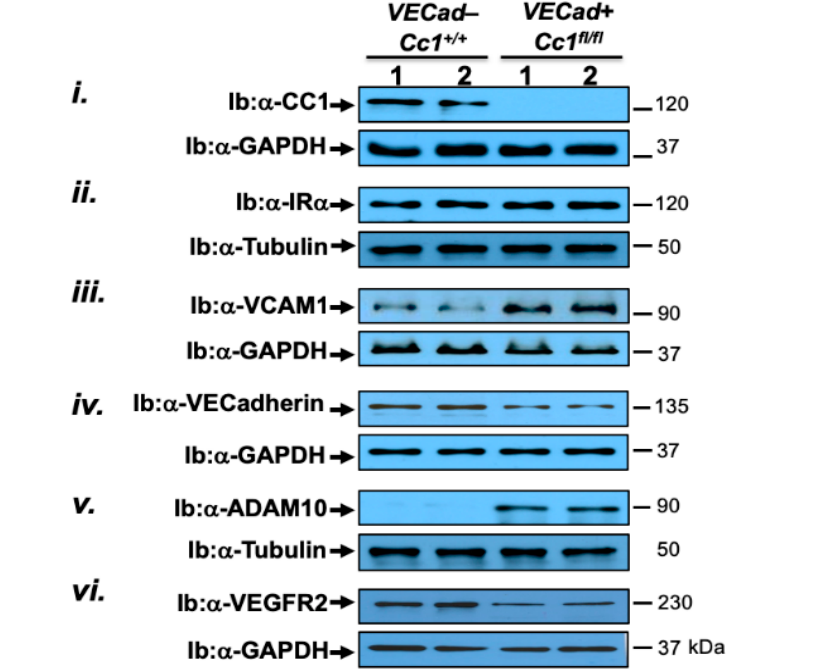
Figure 1. Assessing CEACAM1 expression in endothelial cells. ( A ) Primary cells were isolated from male mice at 2 months of age ( n = 5/genotype), except for hepatic stellate cells that were de- rived from male mice at 8 months of age. Ceacam1 mRNA levels were analyzed by qRT-PCR in triplicate and normalized to 18S. Values are expressed as mean ± SEM. * p < 0.05 vs. all control groups; Negl, negligible. ( B ). Liver endothelial cells (LEC) combined from several wild-type ( VECad-Cc1 +/+ ) and null ( VECad+Cc1 fl/fl ) mice were analyzed by immunoblotting (Ib) with specific antibodies ( α -) to detect specific proteins and normalized against levels of loaded proteins by im- munoblotting parallel gels or lower half-gels with α -GAPDH or α -Tubulin. The apparent molecu- lar mass (kDa) is indicated at the right-hand side of each gel. Gels represent two separate/repeated experiments. 3.2. VECadCre+Cc1 fl/fl Mice Display Insulin Sensitivity Compared to control littermates, VECadCre+Cc1 fl/fl nulls exhibited normal body weight for up to 12 months of age (Figure 2A, data of 8-month-old mice are shown). This was associated with normal visceral adipose mass (Figure 2B). Consistently, plasma levels of NEFA, adiponectin, and leptin were also normal in nulls relative to control littermates (Figure 2C–E, respectively). Null mice displayed normal steady-state plasma insulin (Figure 2F) and C-peptide (Figure 2G) levels. This was associated with normal insulin clearance (calculated as steady-state C-peptide/insulin molar ratio) (Figure 2H), consistent with the intact expres- sion of CEACAM1 in hepatocytes, the major site of insulin clearance and home for the highest level of CEACAM1 expression [3].